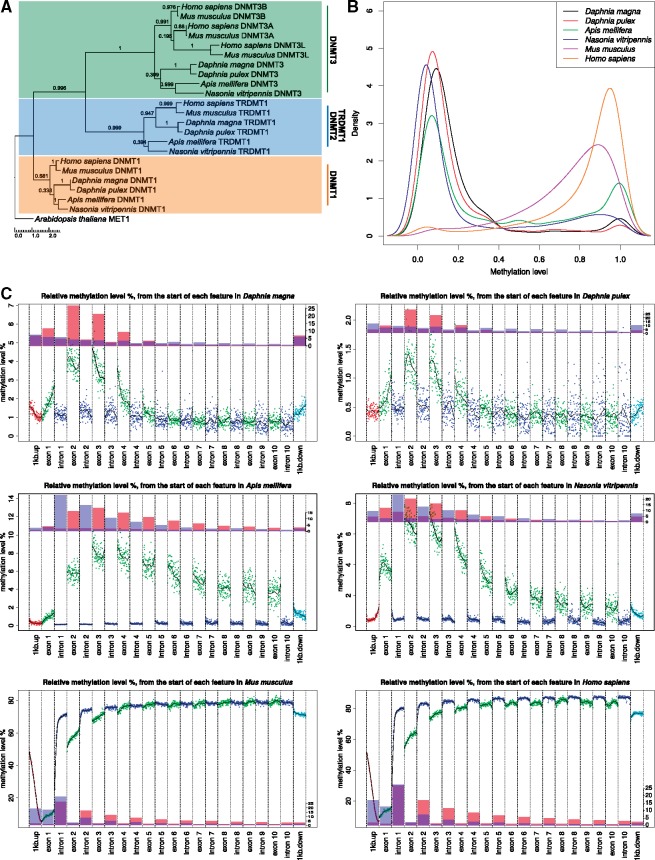
—Genomic overview of DNA methylation levels in four arthropods and two vertebrates. (A) Maximum likelihood phylogeny of methyltransferase proteins in the study species. The phylogeny was estimated for all methyltransferase proteins identified in OrthoFinder analysis, using A. thaliana MET1 as an outgroup. One representative protein for each methyltransferase gene was selected for each species for visualization. The numbers above the branches are aLRT (approximate likelihood ratio test) support values in the phylogeny. The scale bar shows the expected number of amino acid substitutions. (B) A density plot of global methylation levels among the species. CpG sites with zero methylation were excluded from the analysis. (C) Methylation landscape across genomic features. The average methylation level was calculated for CpGs with similar relative distance (0–100) from the start of each genomic feature (exons, introns, 1 kb upstream and downstream of the first and last exon). A loess fit was calculated across each feature. The bar plots represent the relative abundance of high methylated CpGs (methylation level > 50%, HM = red) and LM CpGs (methylation level < 50%, LM = blue) across the genomic features.